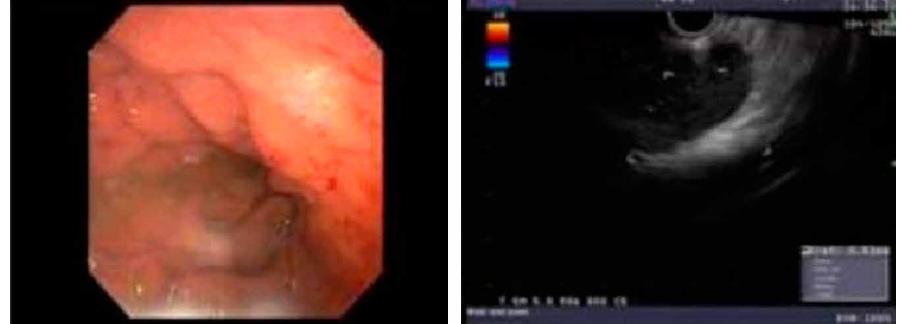
Figure 4: Upper endoscopy with EUS guided biopsy: A large celiac node, measuring about 4 cm in diameter, along with multiple enlarged lymph nodes noted in the porta hepatis and the lesser sac.